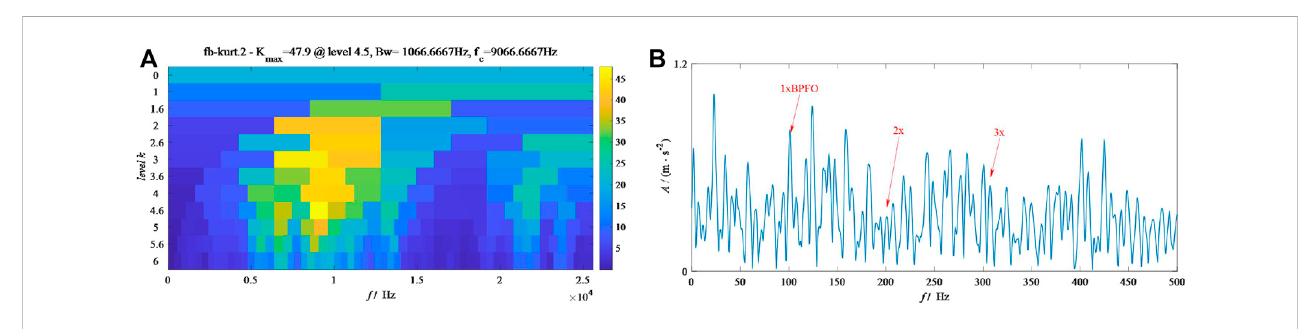
FIGURE 13 Results from FK for signal CU-O: (A) kurtogram and (B)